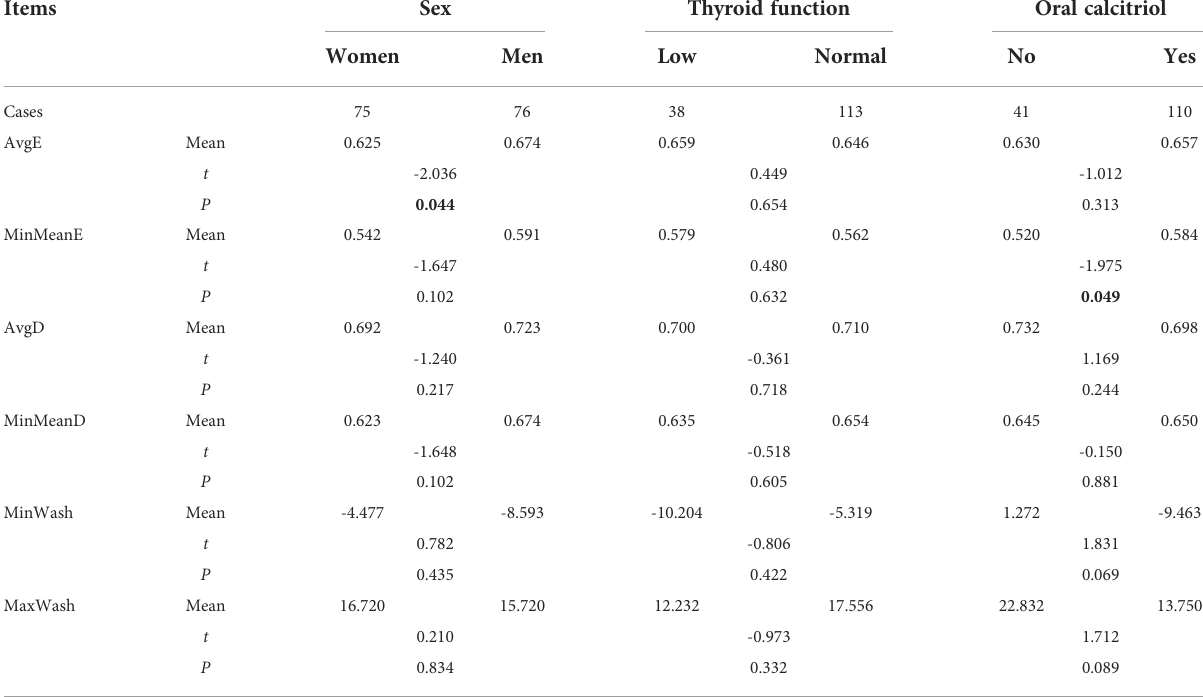
TABLE 2 The comparison of 99m Tc-MIBI uptake TBRs between different sex, thyroid function, or oral calcitriol.